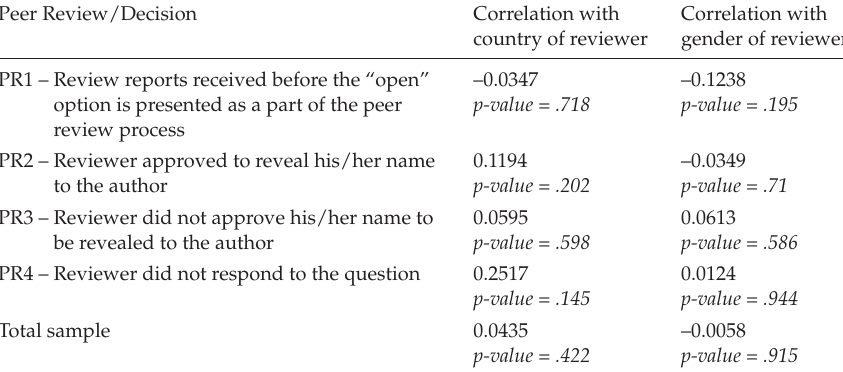
Table 16: Peer review correlation analysis in certain groups of peer review reports regarding the country and gender of